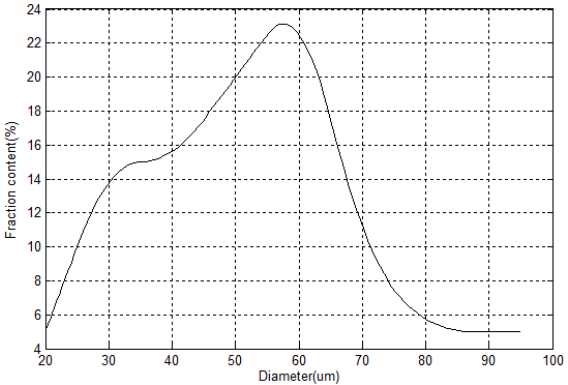
Figure 2. Distribution of diameters of microspheres.